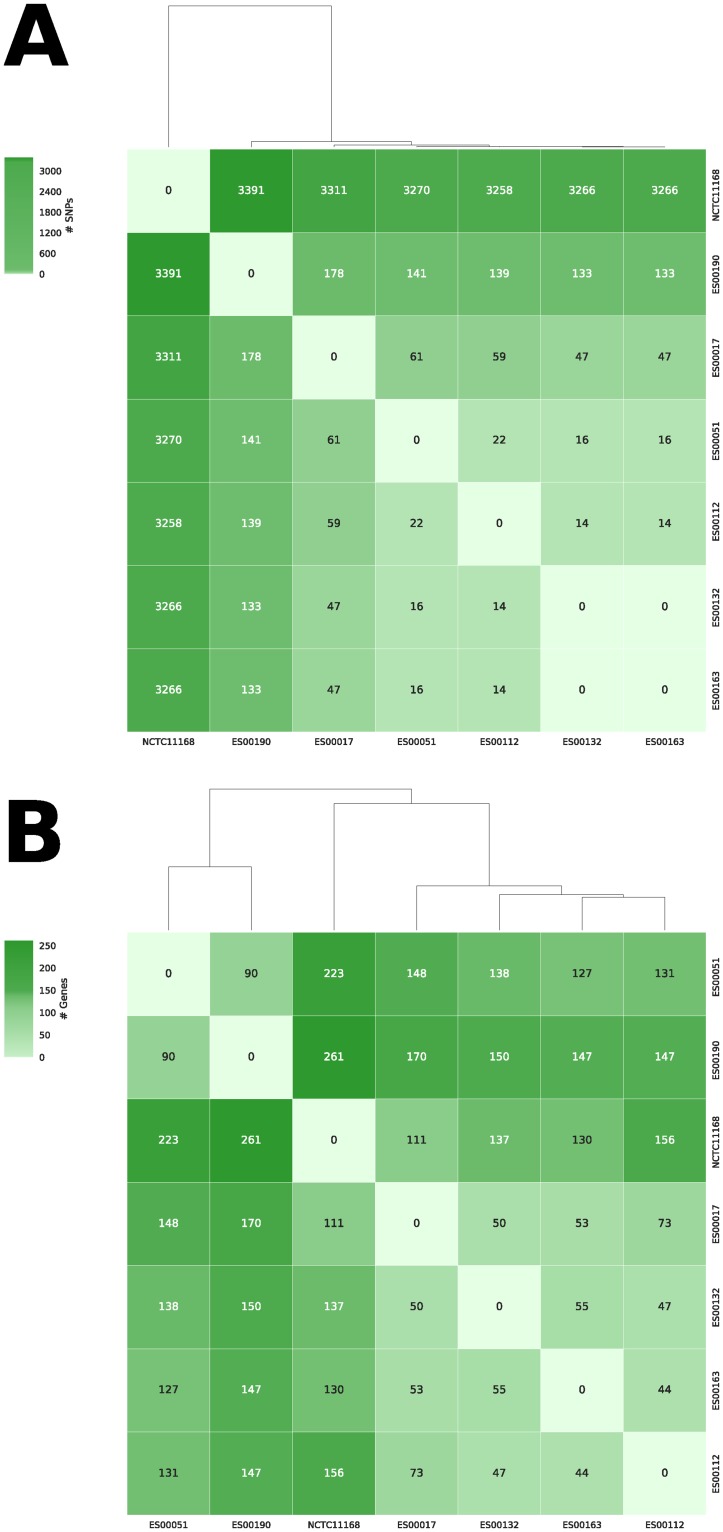
Comparative analysis of the genomes of ST-21 ENIGMA study isolates carrying the T86I mutation.The figure shows (a) the number of SNP differences and (b) the number of genes that differ in terms of presence/absence between the isolates. The reference strain NCTC11168 was included for comparison.